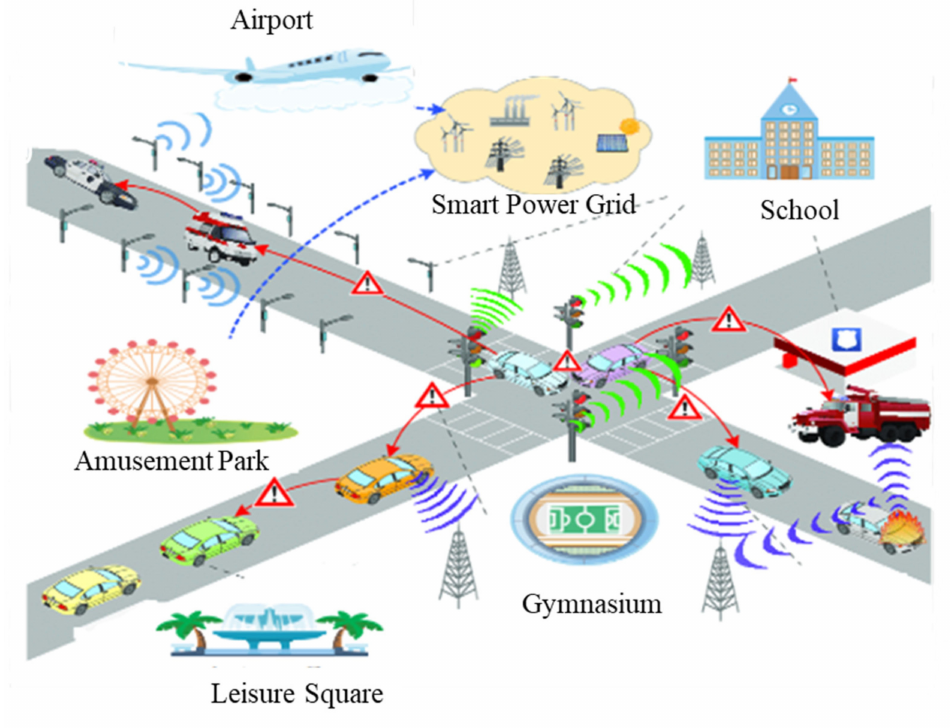
Figure 1. Depicts smart city and intelligent transportation